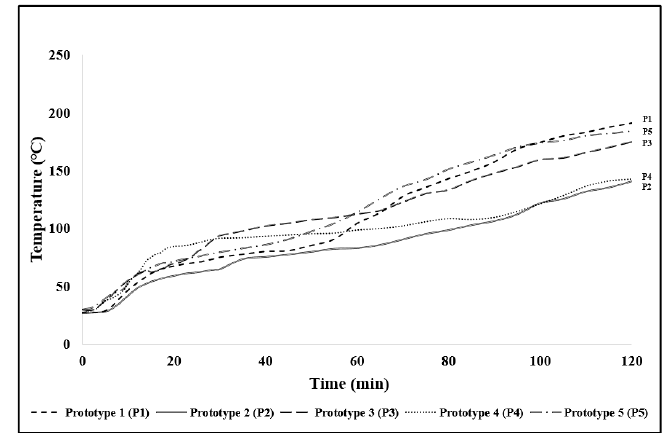
Figure 11. Evolution of temperature of fire-resistant timber door prototypes.